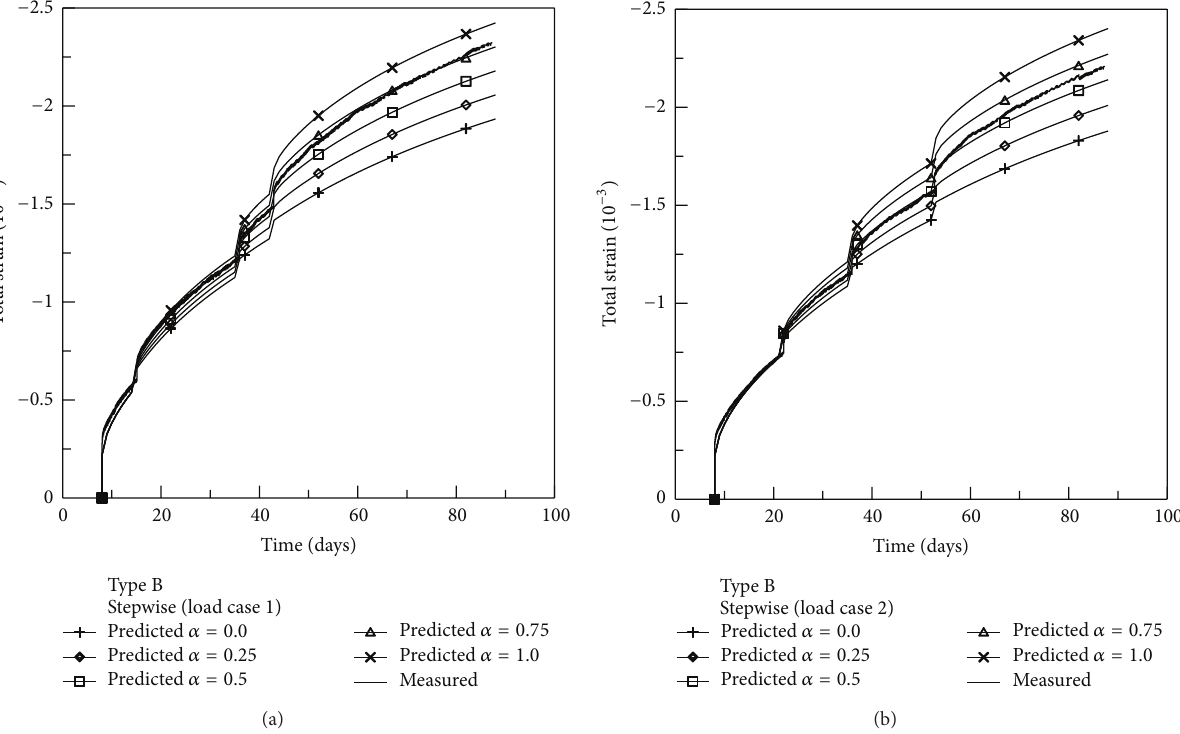
Figure 8: Predicted and measured total strains for the two stepwise load cases of type B test: (a) load case 1 and (b) load case